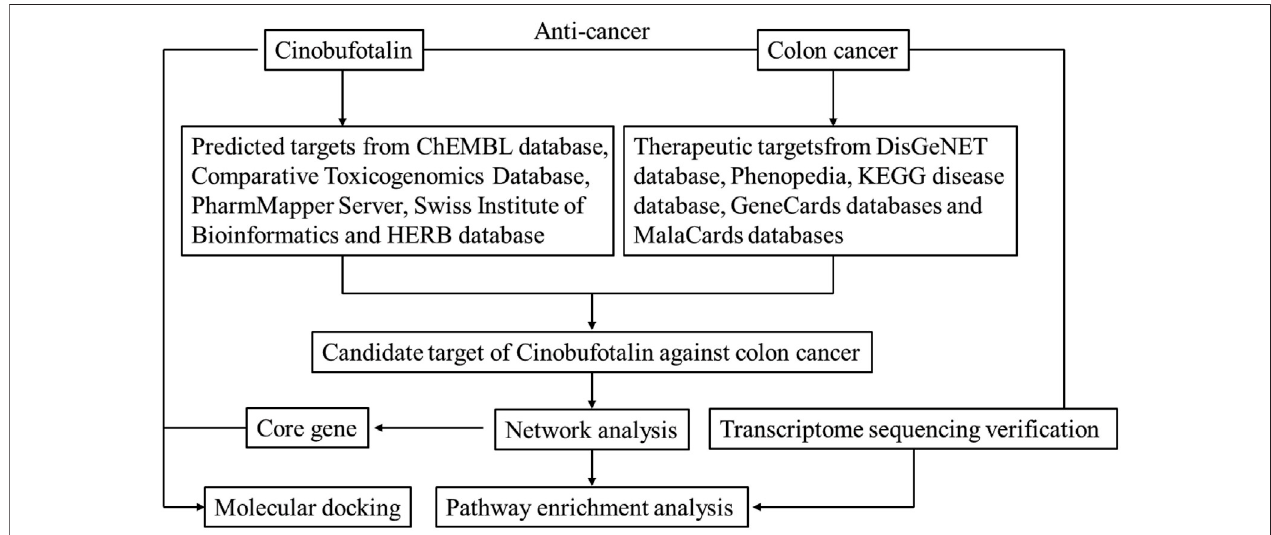
FIGURE 1 | Work fl ow of the systematic strategies to explore the mechanisms of cinobufotalin against colon cancer.